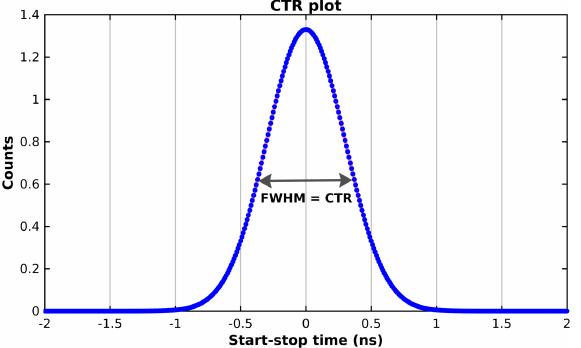
Figure 21. Example of a CTR histogram. The FWHM of the curve is the CTR of the coincident system